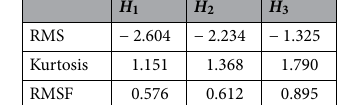
Table 4. Indicator evaluation level and reference value.